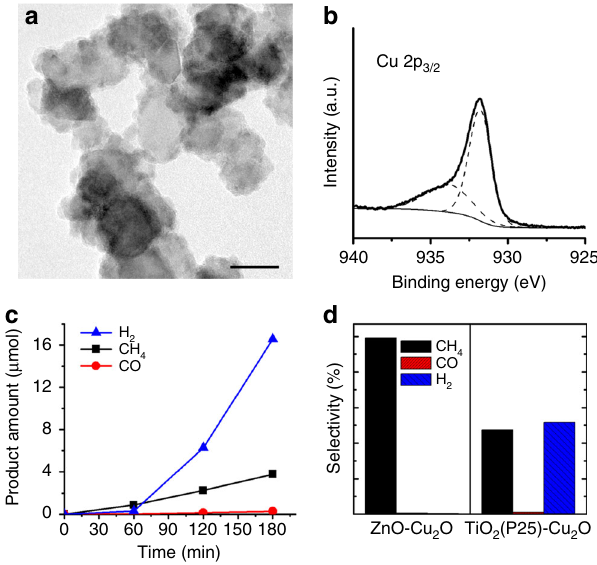
Fig. 4 Comparison to the TiO 2 (P25)-Cu 2 O hybrid catalysts. a TEM image of the TiO 2 (P25)-Cu 2 O hybrid structure. The scale bar represents 20 nm. b XPS spectrum of the TiO 2 (P25)-Cu 2 O hybrid structure in the region of Cu 2p 3/2 . c Amounts of H 2 (blue triangle), CH 4 (black square), and CO (red circle) production using the TiO 2 (P25)-Cu 2 O catalysts as a function of the irradiation time. d Selectivity of gas products using ZnO-Cu 2 O (left) and TiO 2 (P25)-Cu 2 O (right)